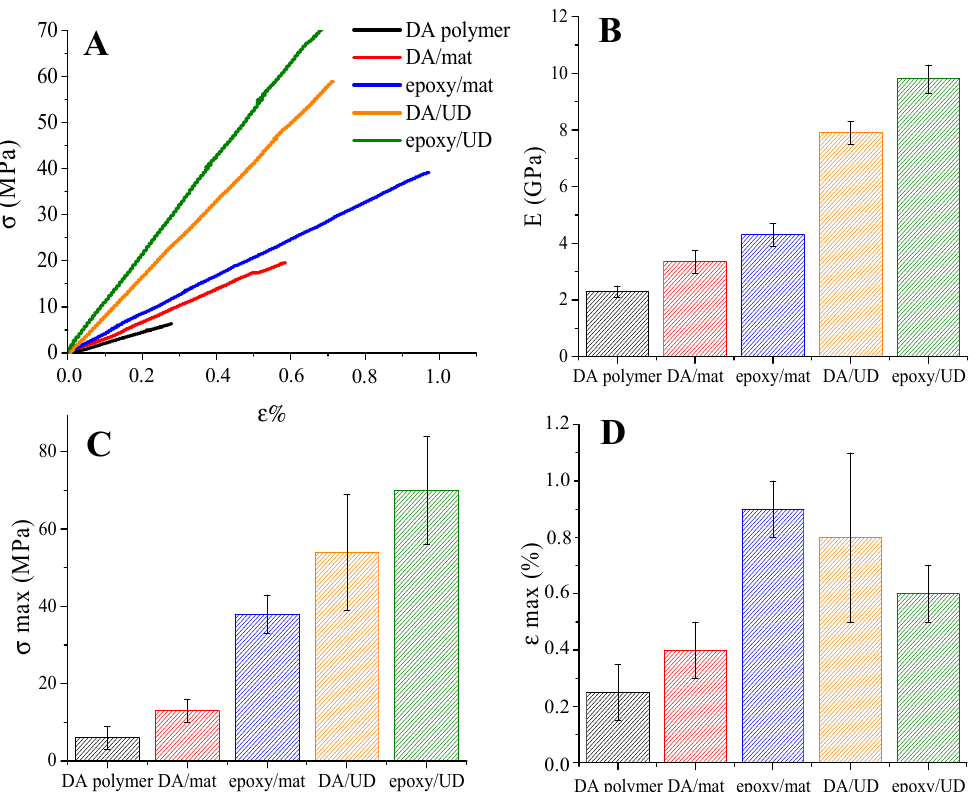
Figure 5. Tensile test results for neat DA polymer and its composites with nonwoven carbon mats (DA / mat) and unidirectional carbon fibers (DA / UD) compared to reference composites (epoxy / mat and epoxy / UD): ( A ) Median stress-strain curves, ( B ) Young’s modulus E, ( C ) tensile strength σ max , and ( D ) maximum strain ε max .